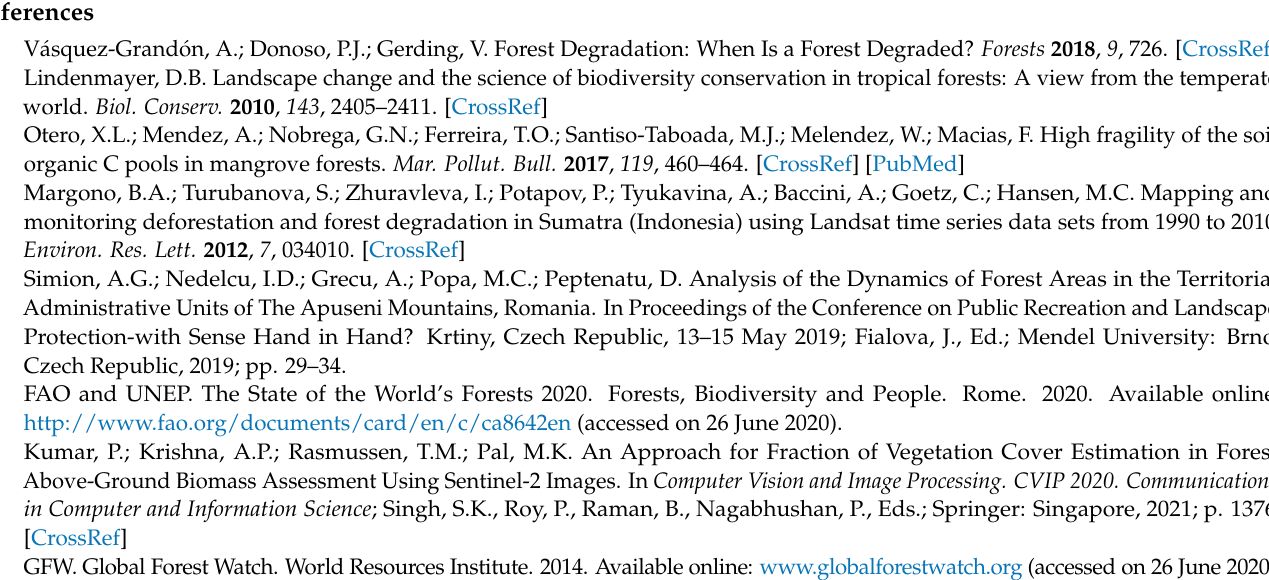
Figure A2. The annual evolution of the TCLR for Mediterranean countries (2001–2019): the blue bars present the annual evolution of TCLR; the green and red bars present the evolution trend of TCLR for the entire period.